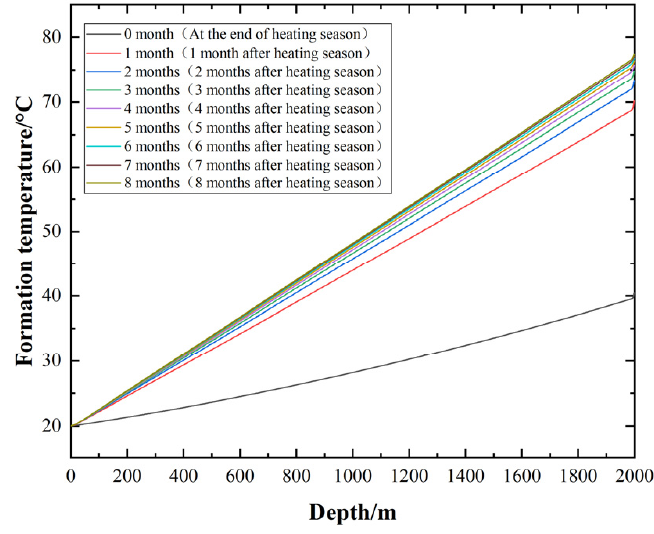
Figure 6. Temperature of the formation near the well during the non-heating season. Table 5 shows the temperature recovery effect of 5, 7 and 9 kg/s month by month. In this table, temperatures at depths of 1000 and 1998 m are listed. The reason for choosing 1998 m instead of 2000 m is that the length of the inner pipe is 1998 m and the length of the outer pipe is 2000 m. When the geothermal water flows from the outer pipe into the inner pipe, it basically flows near a depth of 1998 m. The water at 2000 m basically does not flow. Therefore, observing the temperature change at a depth of 1998 m can better reflect the temperature change. From the table, the temperature recovery effect in the first month is the best, and the temperature recovery effect after the second month is very small. Although the heat extraction rates of different mass flows has a difference, the temperature of the formation of different mass flows is basically the same after eight months. The formation temperature at a depth of 1000 m recovers to 48.15 ◦ C, and for 1998 m, the temperature recovers to 77.25 ◦ C. The initial temperatures at 1000 and 1998 m are 50 ◦ C and 79.94 ◦ C, respectively. The recovery of the formation temperature to a higher level can ensure that there is little effect in heat extraction rates in the second year. In addition, the formation temperature of 1998 m recovers to approximately 73 ◦ C after two months. This time is when a cooling load is needed in summer. If heat is recharged into the formation from the bottom of the well, the temperature of the water in summer needs to be higher than 73 ◦ C. It is very difficult to raise the temperature above 73 ◦ C with a heat pump system. However, if geothermal water is allowed to recharge heat at depths of 1000 m or less than 1000 m, it is much easier to make the water temperature reach 50 ◦ C. If the depth is shallower, the temperature of geothermal water can be lower. Therefore, the effect of cooling and energy storage in summer is